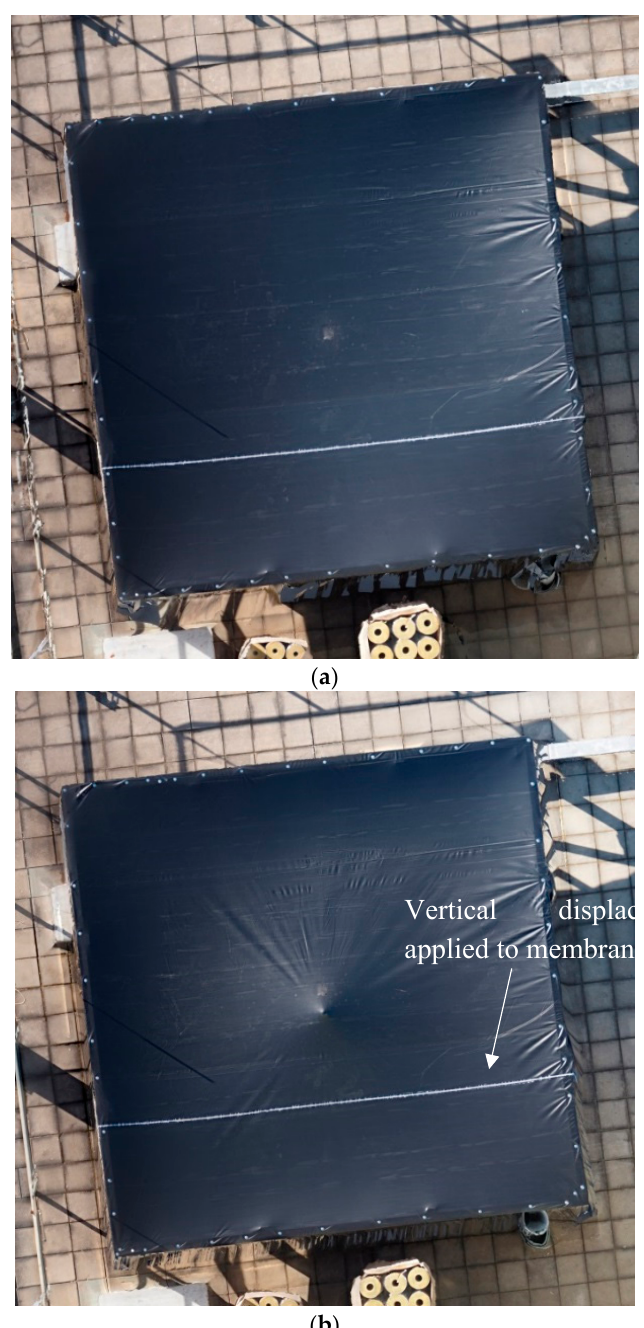
Figure 27. Orthophoto with two different loading conditions: ( a ) “initial” state; and ( b ) “deformed” state.